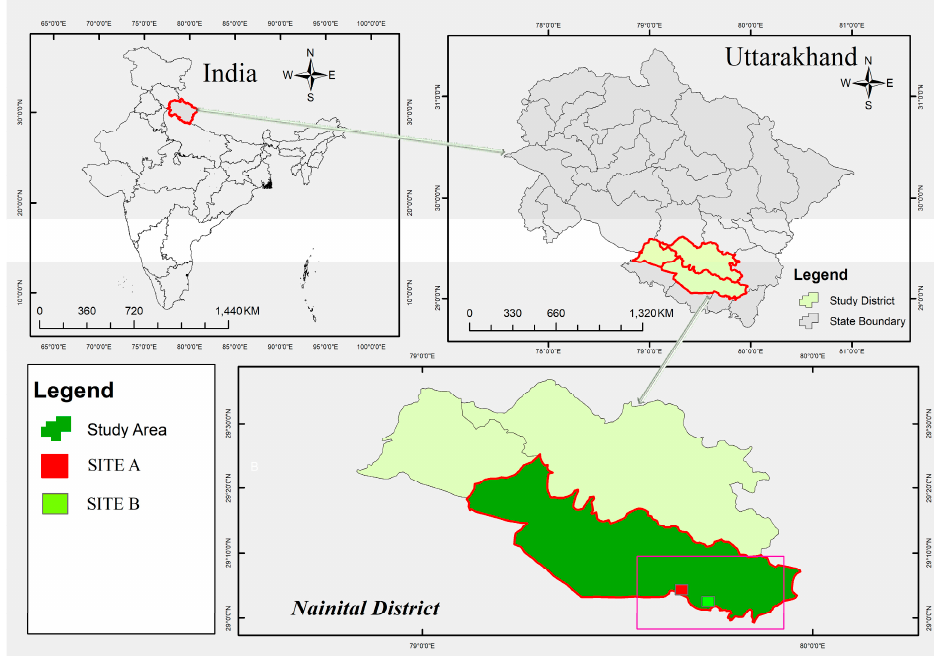
Figure 1. The location map of the study area shows the sampling sites (( A ): D. latifolia plantation; ( B ): M. composita